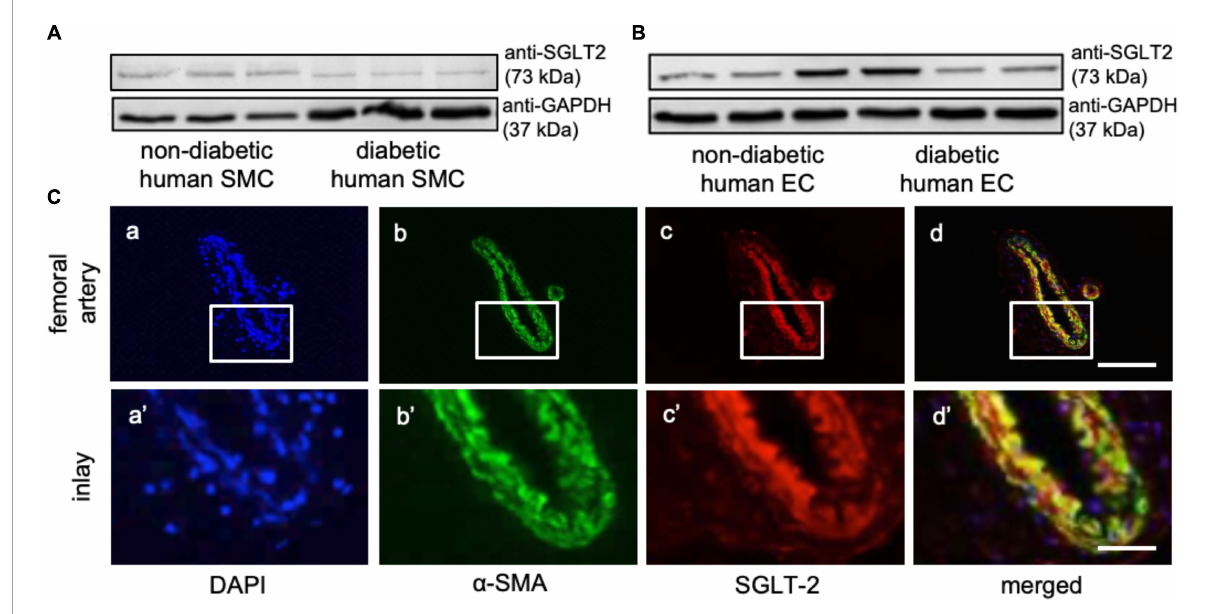
FIGURE1 Sodium glucose co-transporter 2 (SGLT2) is expressed in human vascular cells and the murine femoral artery. (A,B) Western blot analysis for SGLT2 protein expression and glyceraldehyde-3-phosphate dehydrogenase (GAPDH) chosen as loading control in non-diabetic and diabetic human smooth muscle cells (SMCs, n = 3, A ) and endothelial cells (ECs, n = 3, B ). Full-length blots are presented in Supplementary Figure II . (C) Vascular SGLT2 expression in the native murine femoral artery as determined by immunohistochemical co-staining of α -smooth muscle actin ( α -SMA, green) with SGLT-2 (red), and DAPI (blue; n = 6, upper scale bar 100 µ m, lower scale bar 25 µ